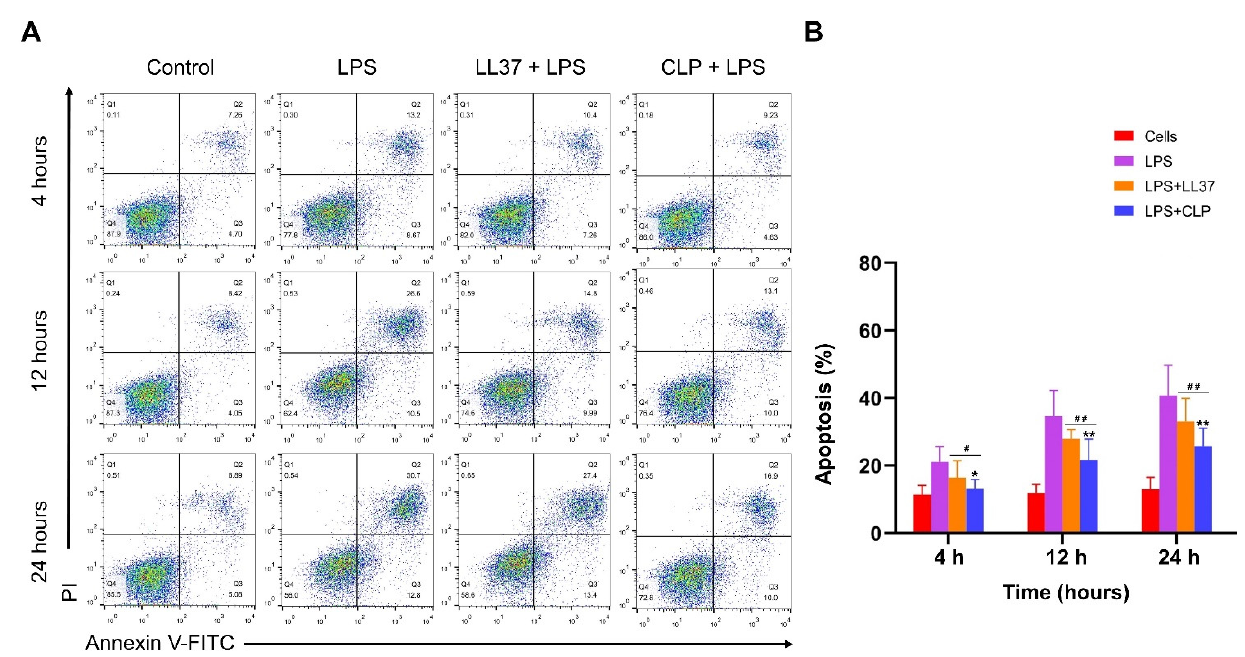
Figure 5. Effects of the parent and hybrid peptides on LPS-induced apoptosis in mouse RAW264.7 macrophages. LPS-induced mouse RAW264.7 macrophages were treated with or without CLP and the parent peptide LL37 at 4, 12, and 24 h. ( A ) Flow cytometry was used to study apoptosis in mouse RAW264.7 macrophages. Normal cells were used as controls, LPS represents cells that have only been treated with LPS; LL37+LPS and LPS+CLP represent cells co-treated with LPS and peptides. ( B ) The apoptosis rate of mouse RAW264.7 macrophages treated with LPS alone or co-treated with peptides. * p < 0.05 and ** p < 0.01 represented the comparison of LPS+CLP vs. LPS. # p < 0.05 and ## p < 0.01 indicated the comparison of LPS+LL37 vs. LPS+CLP.